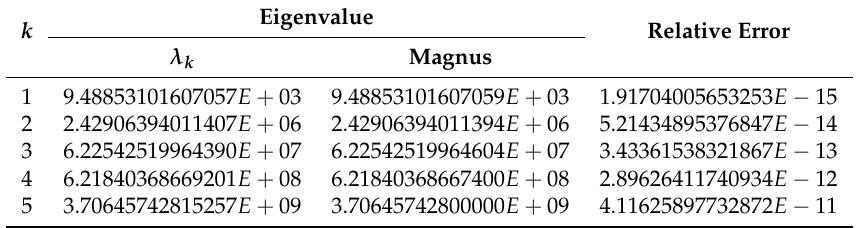
Table 10. Eigenvalues and relative errors for the problem in Equation (38) using m = 100, n = 100, and L =